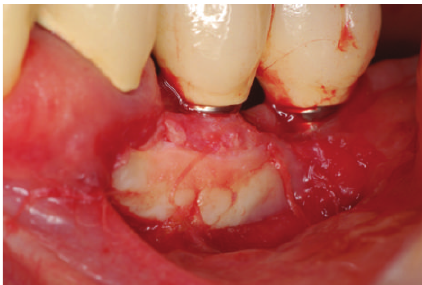
Figure 17: Graft sutured into the recipient site only in keratinized mucosa and periosteum.